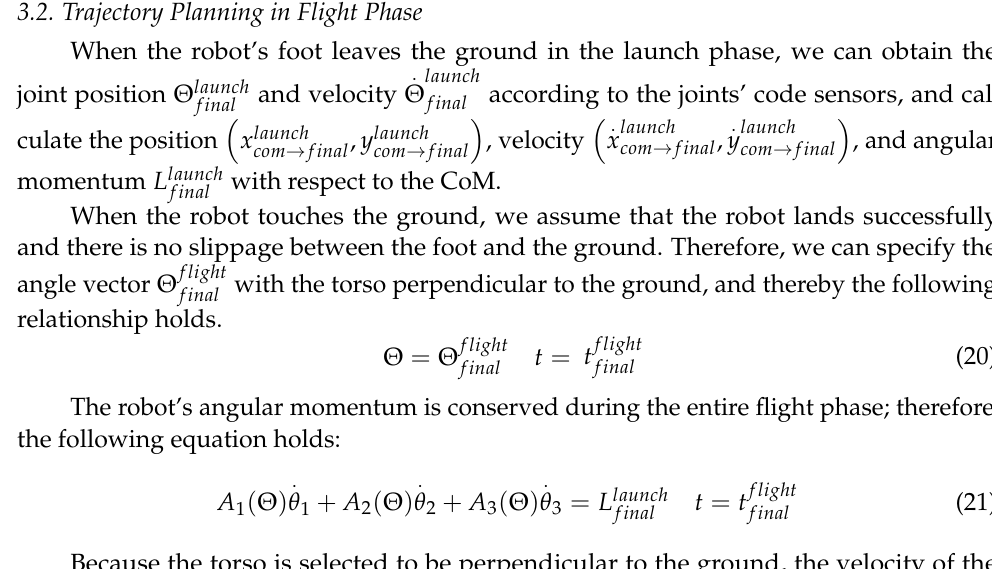
Figure 3. Trajectories of the joints and center of moment (CoM) in the launch phase. ( a ) trajectory of joints in the launch phase; ( b ) trajectories of CoM and zero moment point (ZMP) in the launch phase.